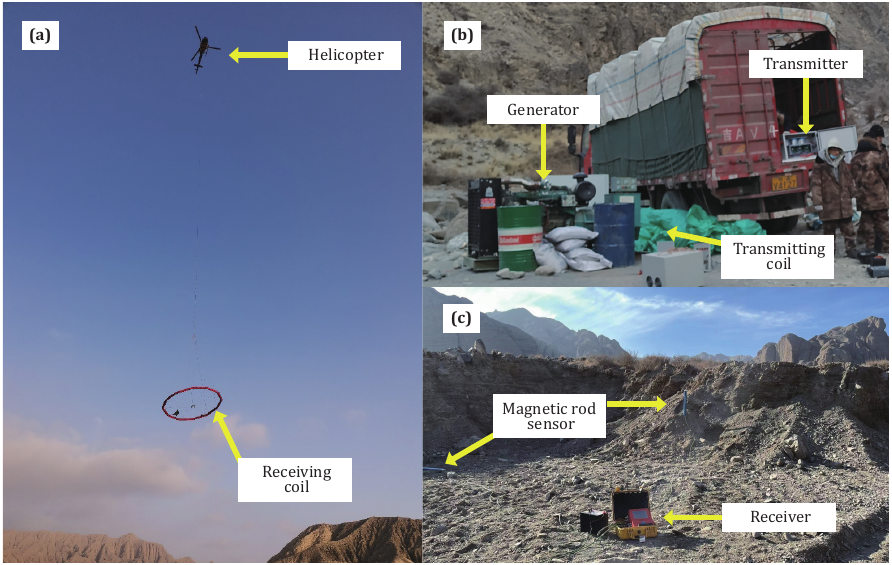
Figure 4. GAFEM system on survey. ( a ) Airborne magnetic recording system. ( b ) Ground high-power transmitting system. ( c ) Ground electromagnetic reference station.